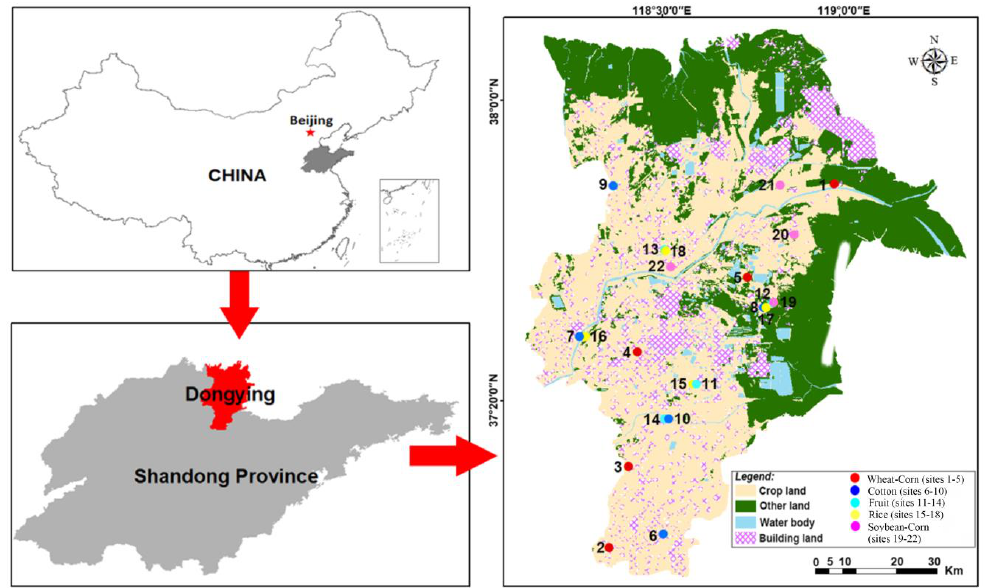
Figure 1. Location of the 22 sites collected from the Yellow River Delta, China according to crop type,